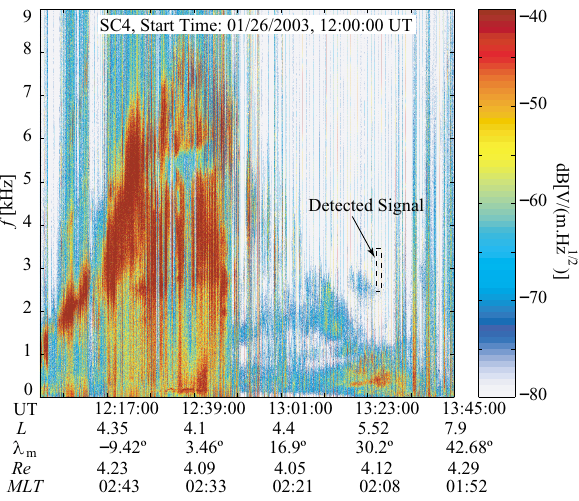
Fig. 7. WBD overview spectrogram from the Cluster satellite pass during 26 January 2003, starting at 12:00:00 UT. The magnitude scale refers to electric field intensity,. The time and frequency range in which the HAARP signal was detected during this date is indi- cated by a dashed-line rectangle. Information about the location of the spacecraft, the L shell, Magnetic Local Time (MLT) the radial distance to the Earth (Re) and magnetic latitude ( λ m ) is shown be-